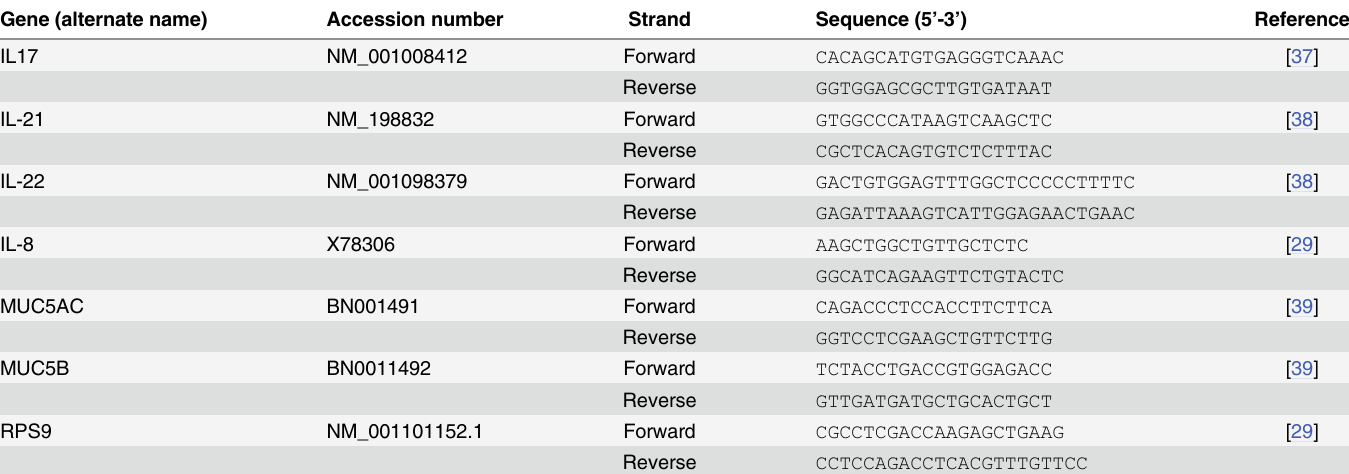
Table 1. Primers used for